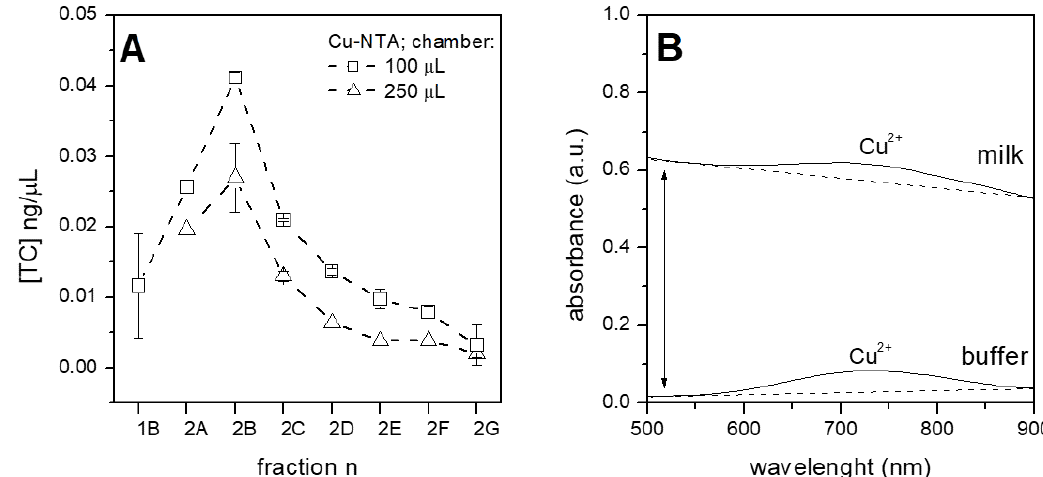
Figure 7. Purification of tetracycline spiked in raw milk. Panel ( A ): Cu-NTA beads were loaded either in 100 µL chamber (squares) or in 250 µL chamber (triangles) and tetracycline was purified with the microfluidic system; and Panel ( B ): spectroscopic analysis of the eluted fractions, starting from tetracycline spiked in buffer (lane named “buffer”) or in raw milk (lane “milk”). Peaks evidence the presence of copper ions (similar for both samples, as evidenced from the dotted lines). Absorbance was normalized to allow the comparison of